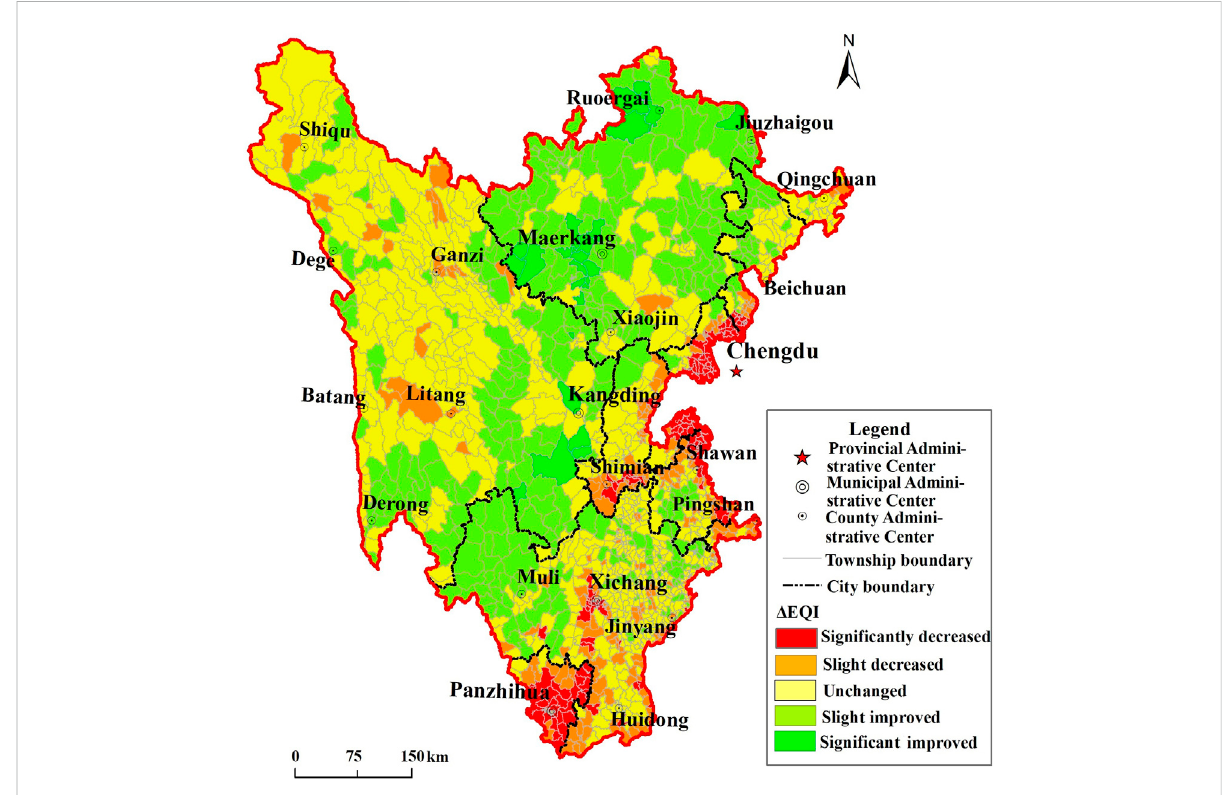
FIGURE 10 The changes of Eco-environmental quality Index between year 2009 and 2019 ( Δ